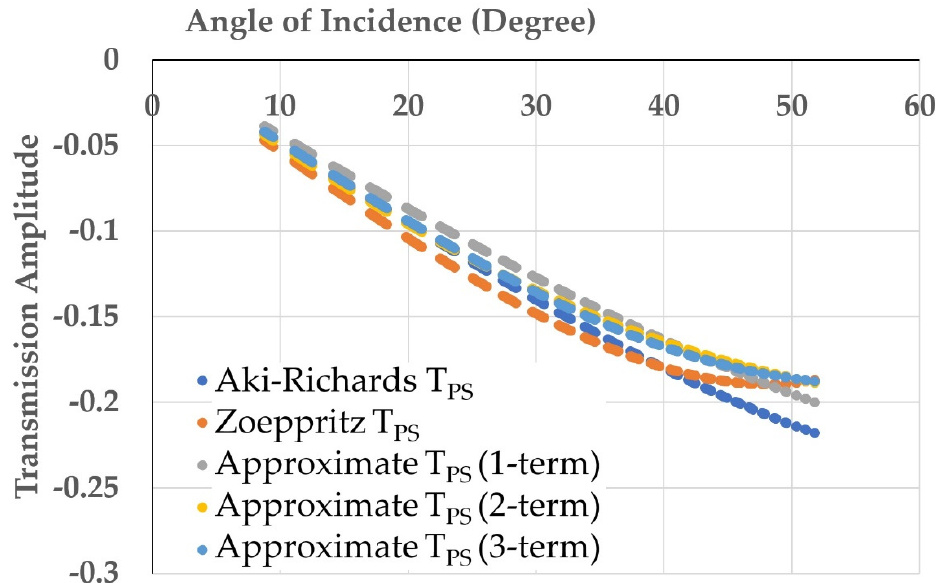
Figure 6. Fitting angle–amplitude (T PS ) data of CTP 63 in the gas channel. Table 5. Values of fitting parameters for CTP 63 in the gas